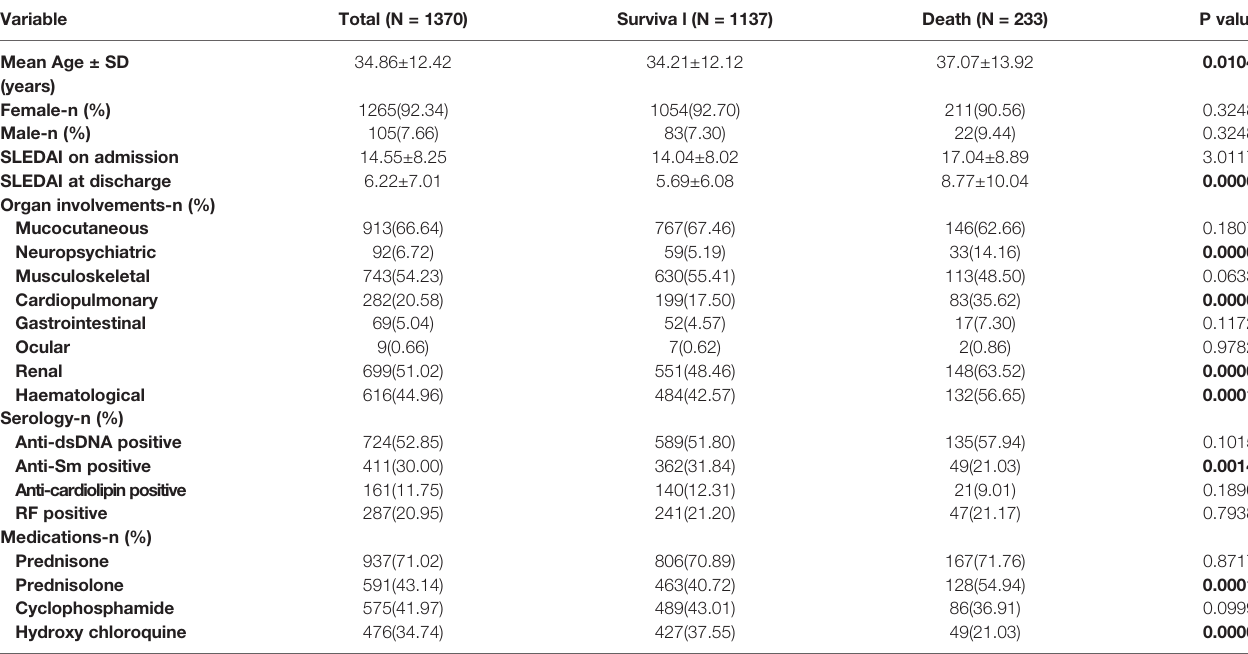
TABLE 1 | Demographic and clinical characteristics of follow-up h-SLE